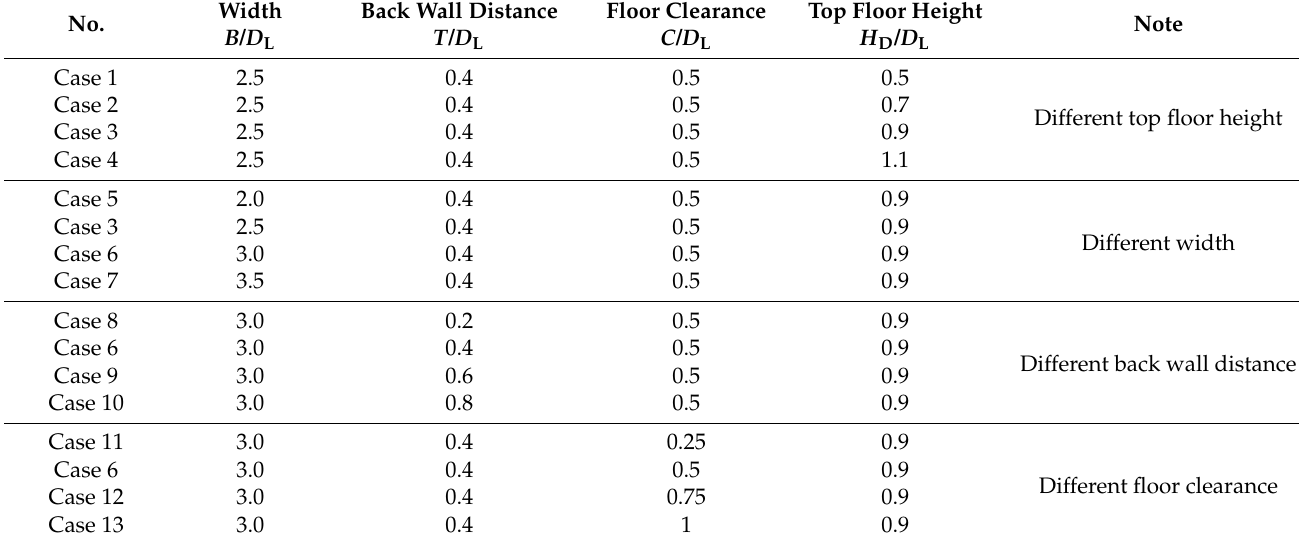
Table 3. Research